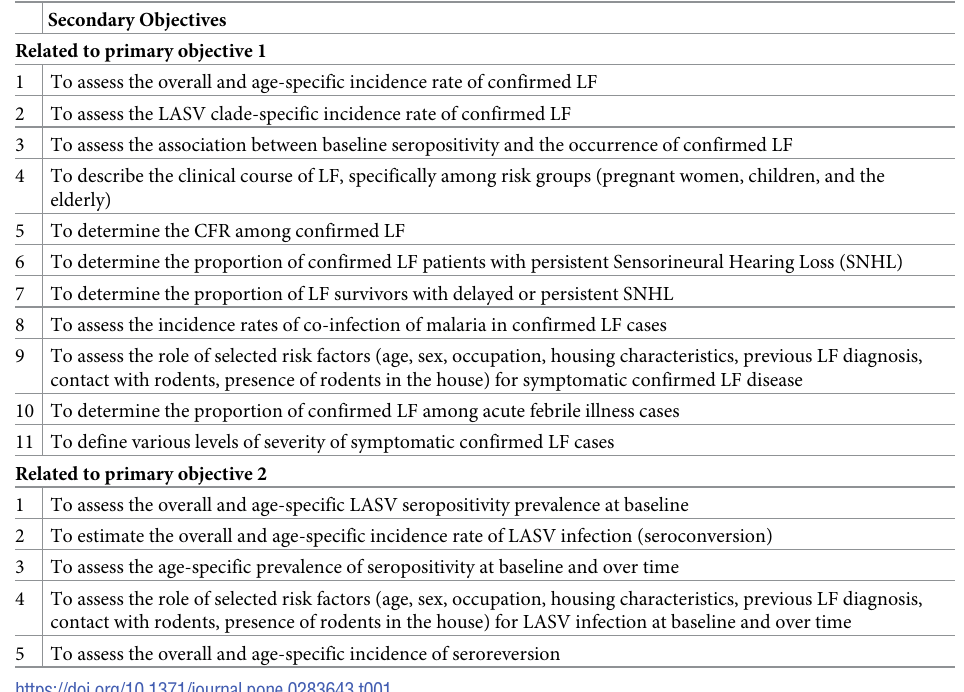
Table 1. Secondary objectives of the Enable Lassa research